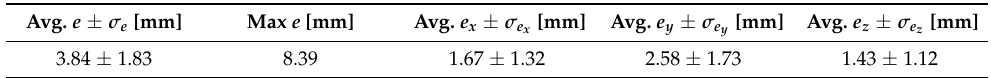
Table 1. Results of simulation tests for the task of TCP positioning of the robot at a given point and avoiding an